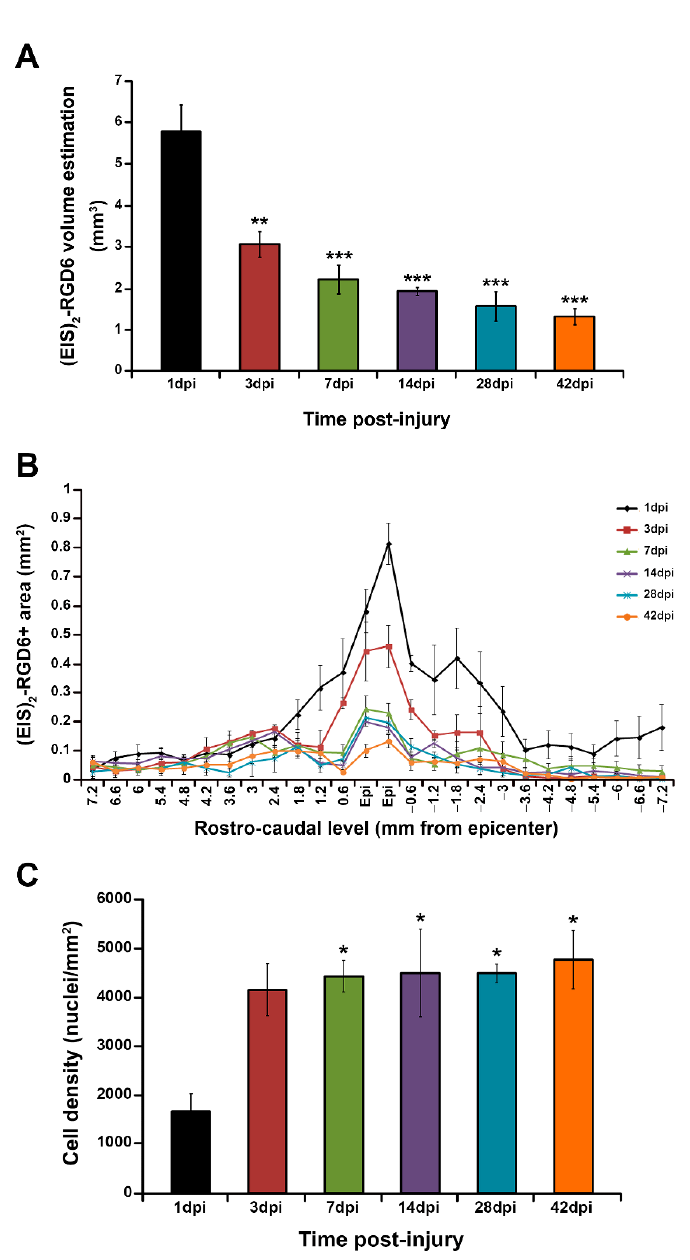
Figure 13. Quantitative analysis of (EIS) 2 -RGD6 degradation and cell infiltration. Graphs show data obtained from the quantification of biotinylated (EIS) 2 -RGD6 degradation and cell infiltration [experiment (EIS) 2 -RGD6 II] at 1, 3, 7, 14, 28, and 42 days post-injury (dpi): ( A ) data obtained from quantification of the temporal evolution of (EIS) 2 -RGD6 estimated total volume (**, p < 0.01 and ***, p < 0.001 vs. 1 dpi); ( B ) data obtained from the quantification of the temporal evolution of (EIS) 2 - RGD6+ area at each evaluated rostro-caudal level; and ( C ) data obtained from the temporal evolution of cell density in the (EIS) 2 -RGD6 porous scaffold in the lesion epicentre (*, p < 0.05 vs. 1 dpi). In ( A , C ), the potential existence of statistically significant between-group differences was assessed by one-way ANOVA followed by the Bonferroni post-hoc test.